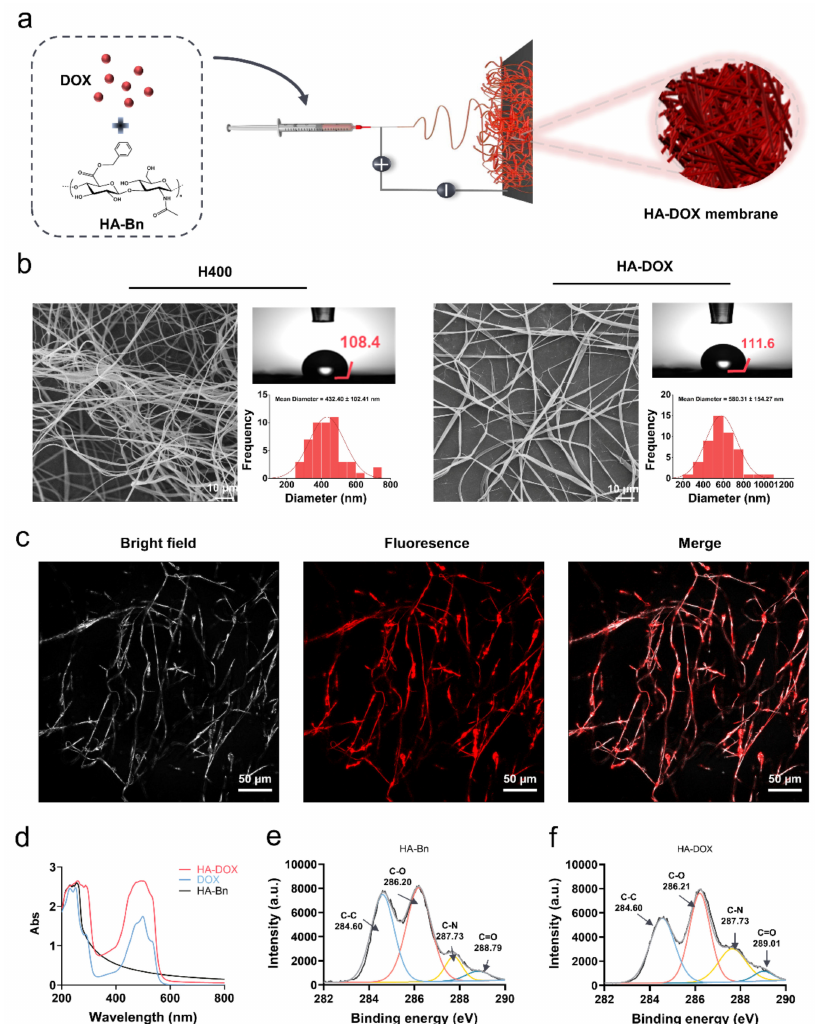
Figure 4. ( a ) Schematic diagram of HA-DOX electrospinning. ( b ) SEM and water contact angle images of nanofiber with or without DOX, and corresponding diameter distribution. ( c ) CLSM images of HA-DOX nanofiber. ( d ) Ultraviolet absorption spectrum of samples. ( e ) C 1s XPS spectrum of HA-Bn and ( f )